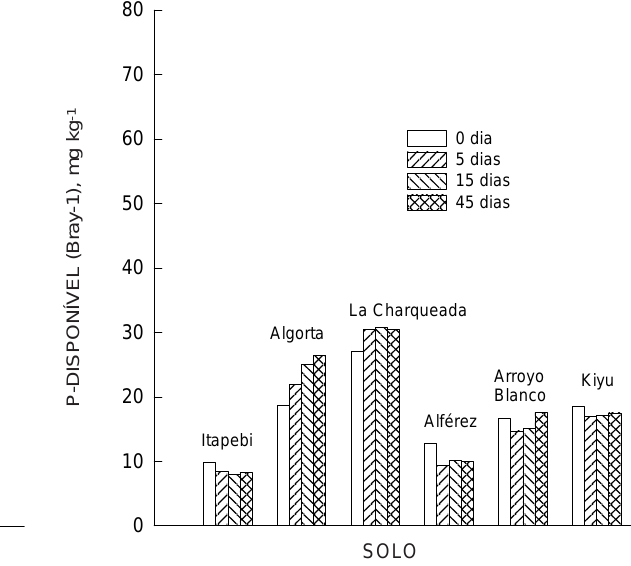
Figura 3. Teores de fósforo disponível por Bray-1 nos seis solos, nas amostras originais e após serem submetidas aos períodos de alagamento e de secagem por 21